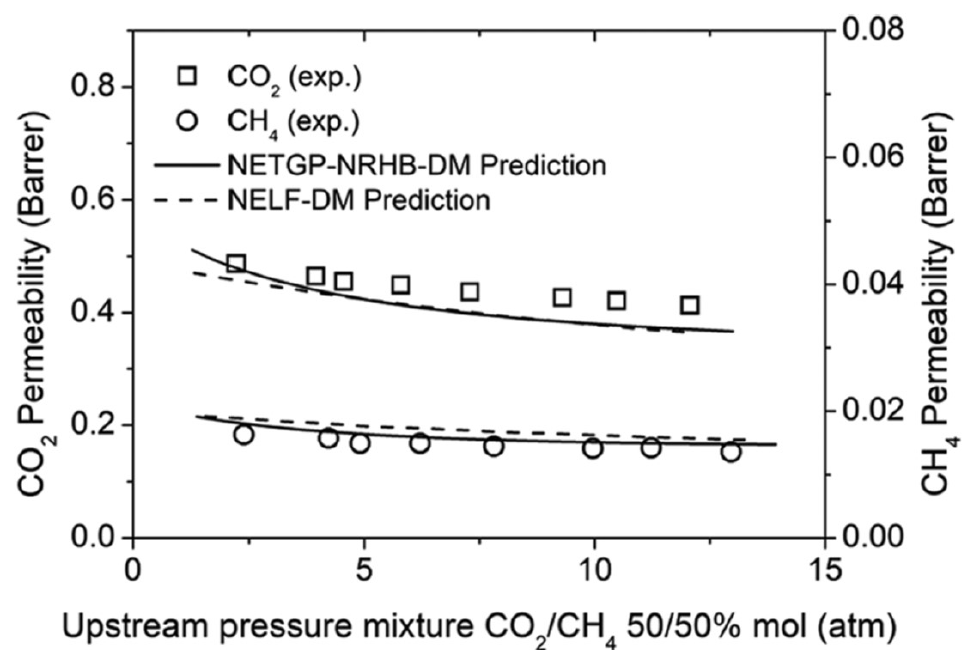
Figure 14. CO 2 and CH 4 mixed-gas permeability in polyhydroxyether (PH) at 35 ◦ C modelling using the NE-NRHB or the NELF models within the STM approach. Reproduced with permission from Ref. [159]. Copyright 2022, American Chemical Society.